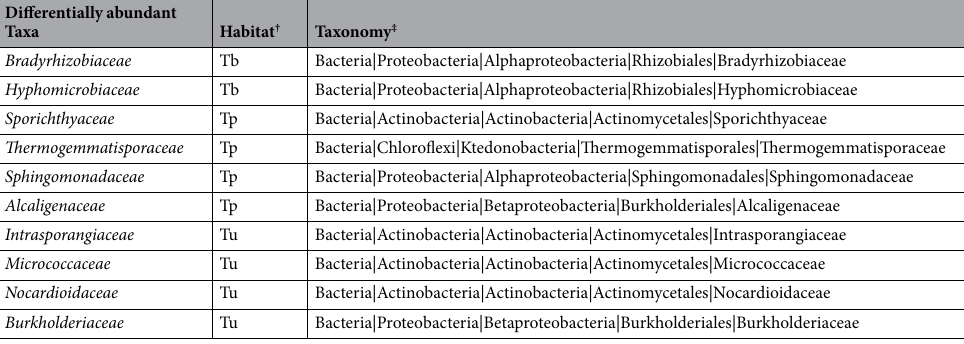
Table 3. Summary table showing differentially abundant bacterial clades at the Family level detected by LEfSe. † Column labelled “Habitat” represents the petroleum contaminated environment in which the corresponding taxa (as presented in column labelled “Differentially abundant Taxa”), was found to be significantly differentially abundant by LEfSe using the one class, non-strict test (Please refer to Materials and methods, and Supplementary Table S2 for details). Acronyms represent the following habitats: A: Arctic, C: China oil refineries, I: India oil refineries, M: Mangrove, DWH: Marine sediments, OSC: Oil sands core, OSTPu: Oil sands tailings pond upper, OSTPm: Oil sands tailings pond median, OSTPd: Oil sands tailings pond deep, Tb: Taiga bottom active layer, Tu: Taiga upper active layer, Tp: Taiga permafrost layer. ‡ Taxonomy is described using the following hierarchy: